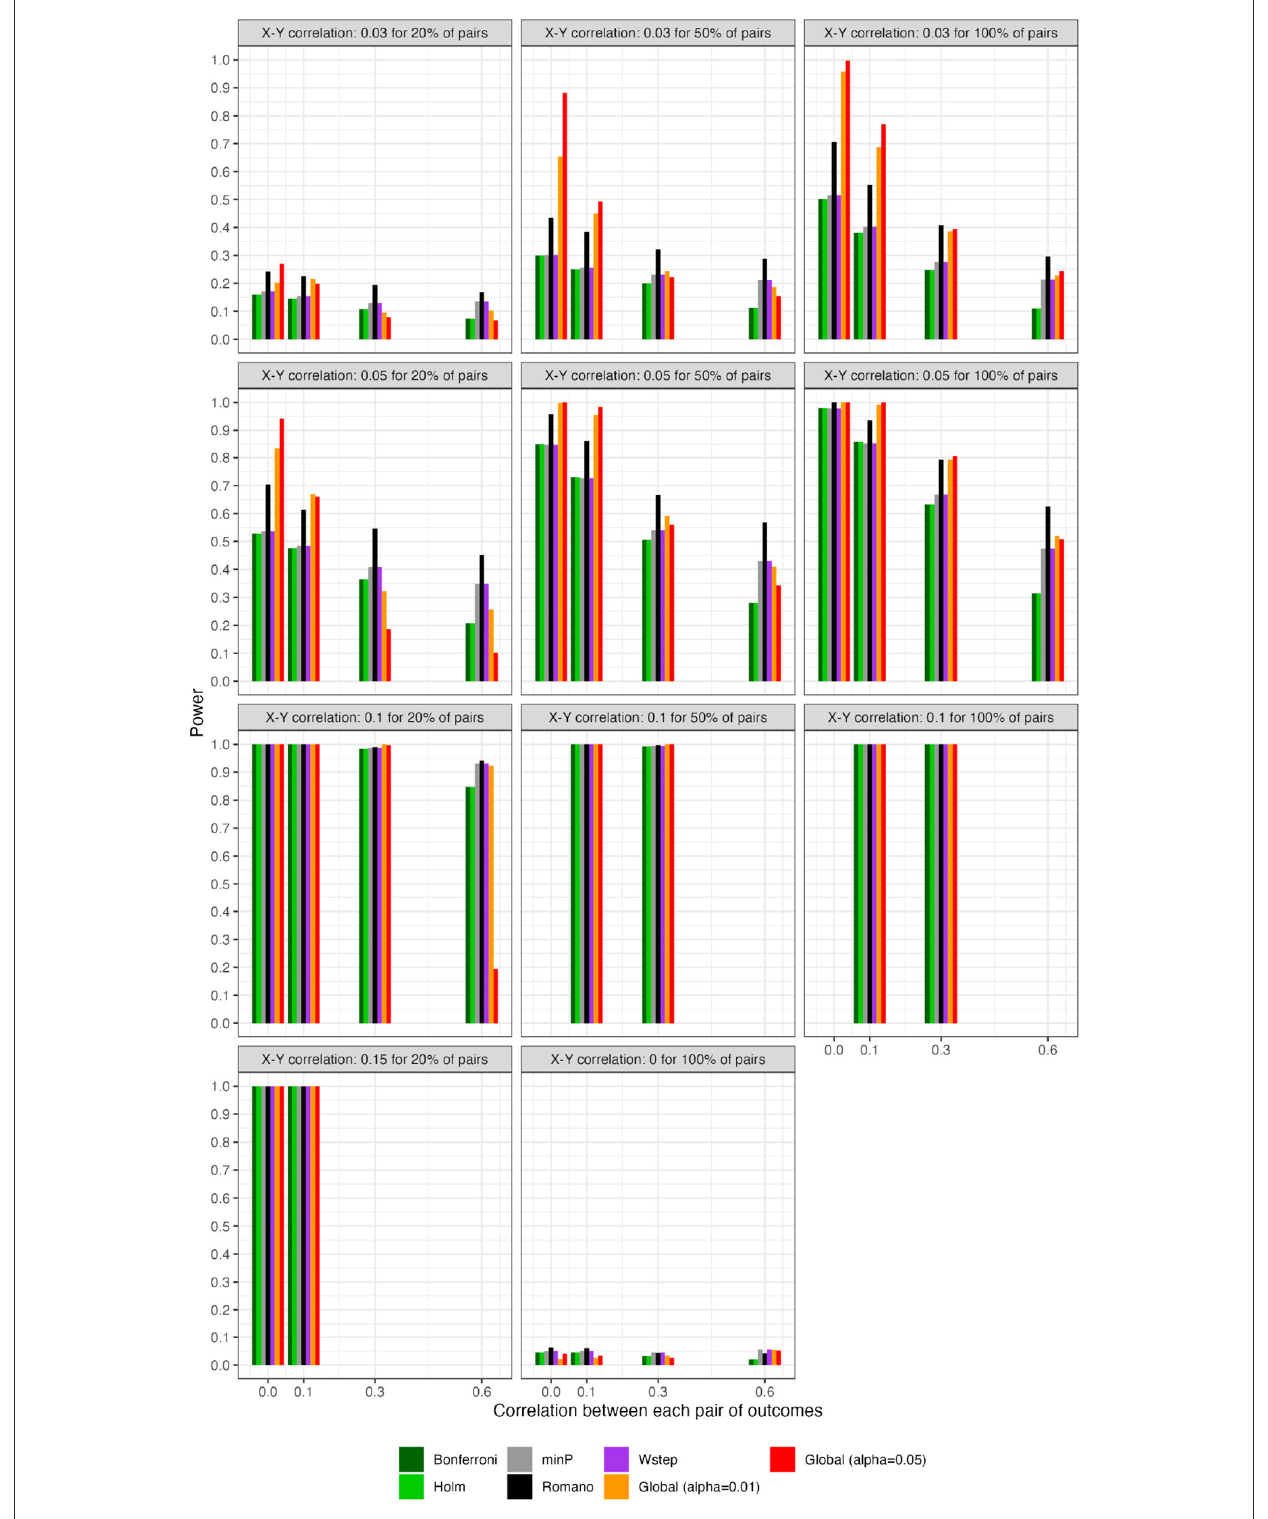
FIGURE5 For scenarios with 200 outcomes, power of global tests based on existing FWER-control procedures and on the number of rejections. “Global (alpha = 0.01)” and “Global (alpha = 0.05)”: proposed methods. The final panel represents Type I error under the global